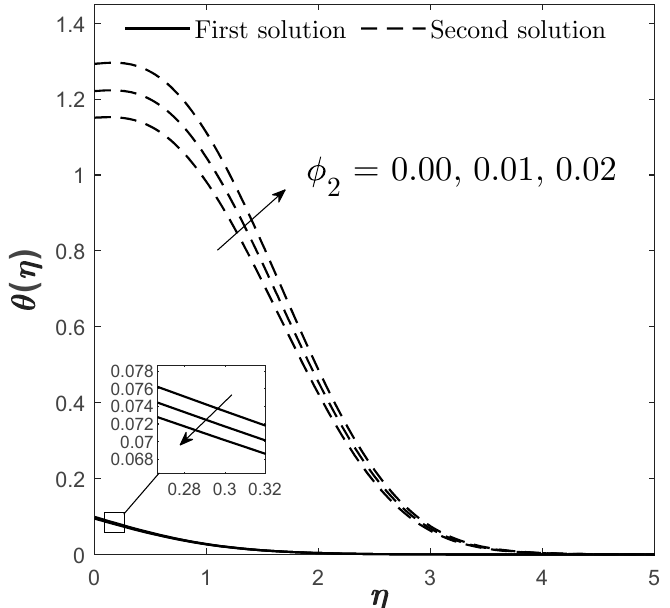
Figure 12. Plots of θ ( η ) for varied φ 2 when N = Rd = Sc = Sr = 1, λ = − 1, Du = 0.03, and Bi = 0.1.